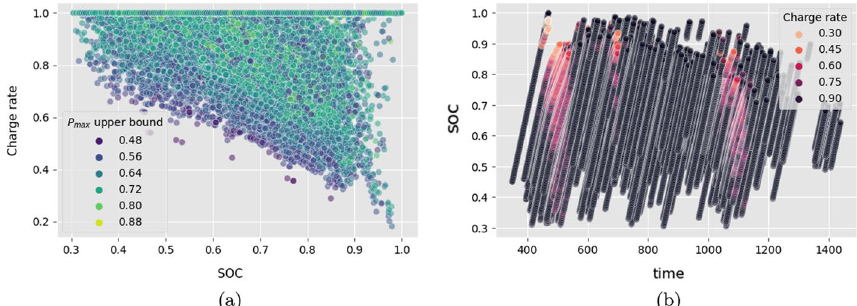
Fig. 7 a Relationship between the SOC and charging rates, b Charging trajectories of the EVs. Observe that there is a reduction of the charging rate as the SOC of the vehicle increases, particularly when the charging demand is high (e.g., between time steps 400 and